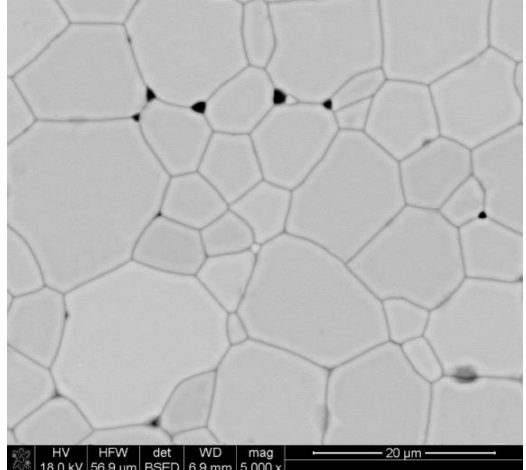
Figure 3. SEM micrographs of the sample sintered at 1400 ◦